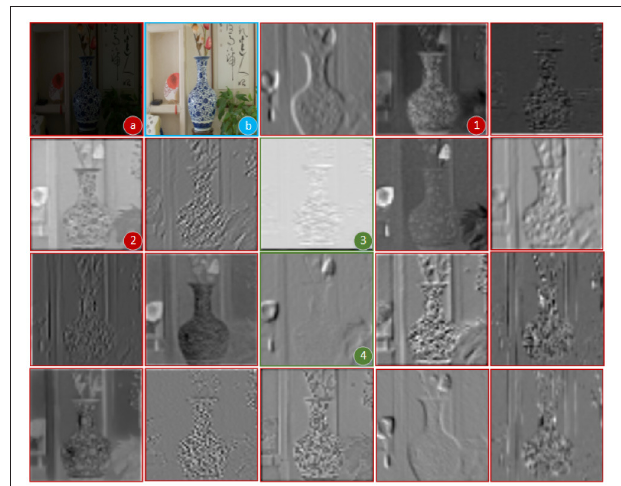
FIGURE 4 | Grayscale map of each channel generated by channel